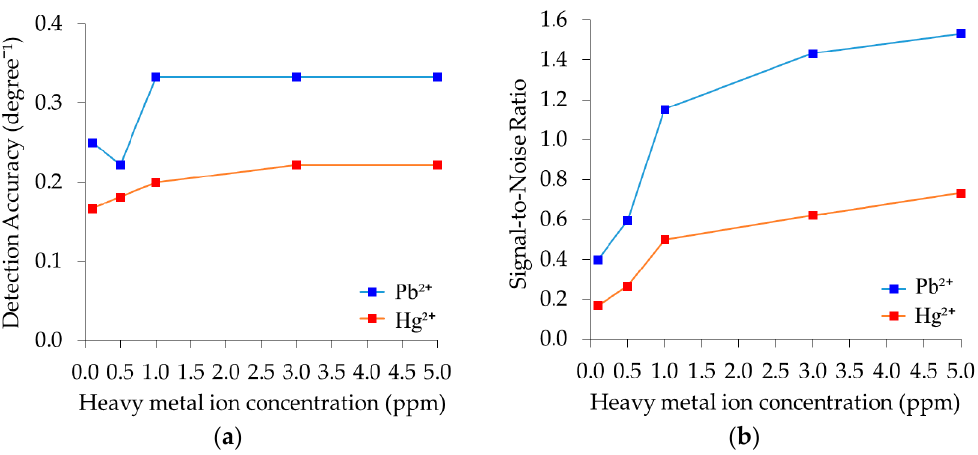
Figure 8. ( a ) Detection accuracy and ( b ) Signal-to-noise ratio of the Au/Ag/Au/CS–GO SPR sensor in Pb 2+ and Hg 2+ ions.